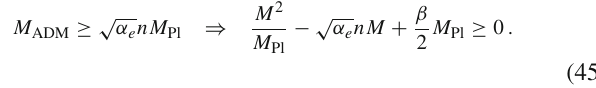
The novel behaviour in Fig. 6 can be explained as